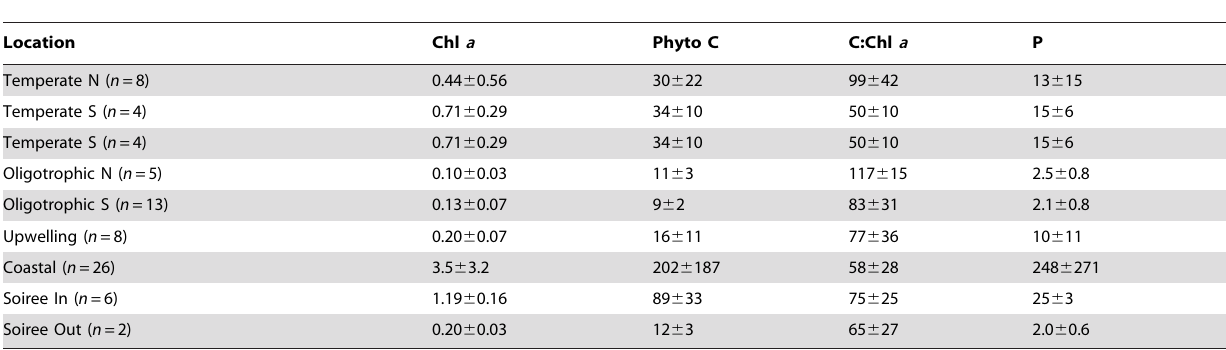
Table 2. Phytoplankton properties at the studied regions.